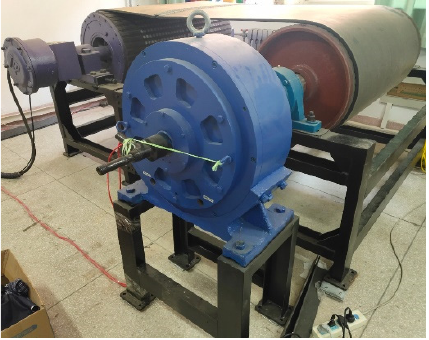
Figure 17. Prototype and experimental platform.